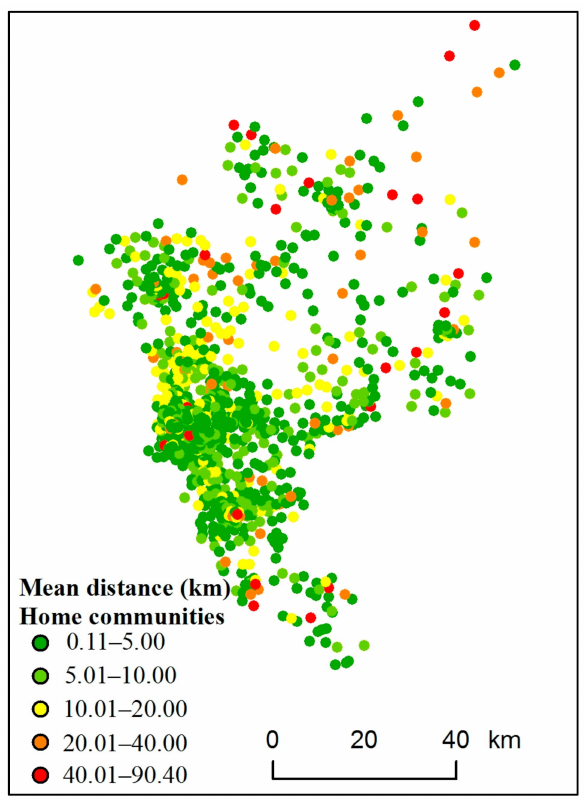
Figure 2. Mean distance at the home community